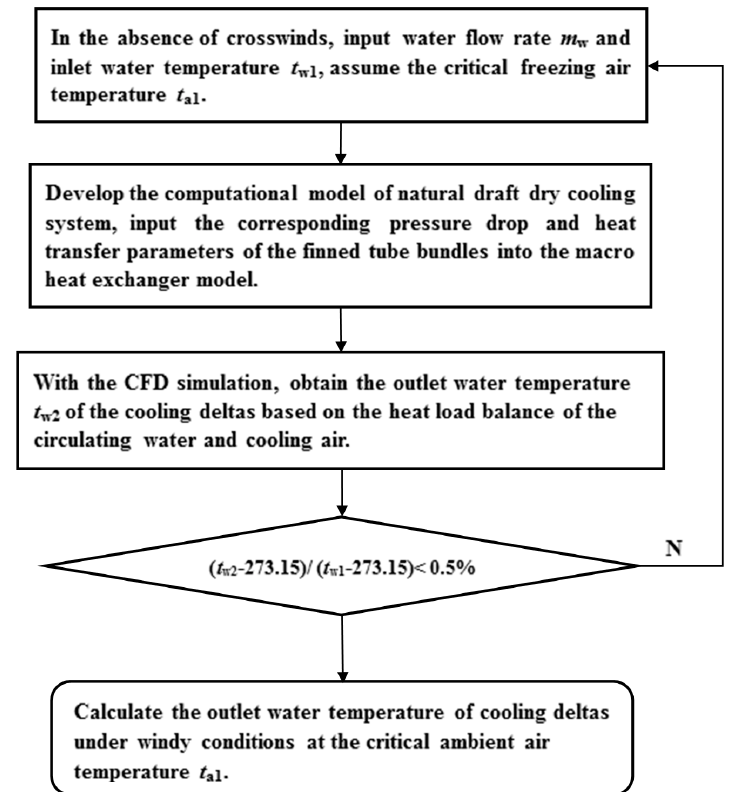
Figure 5. Flowchart for the numerical process.